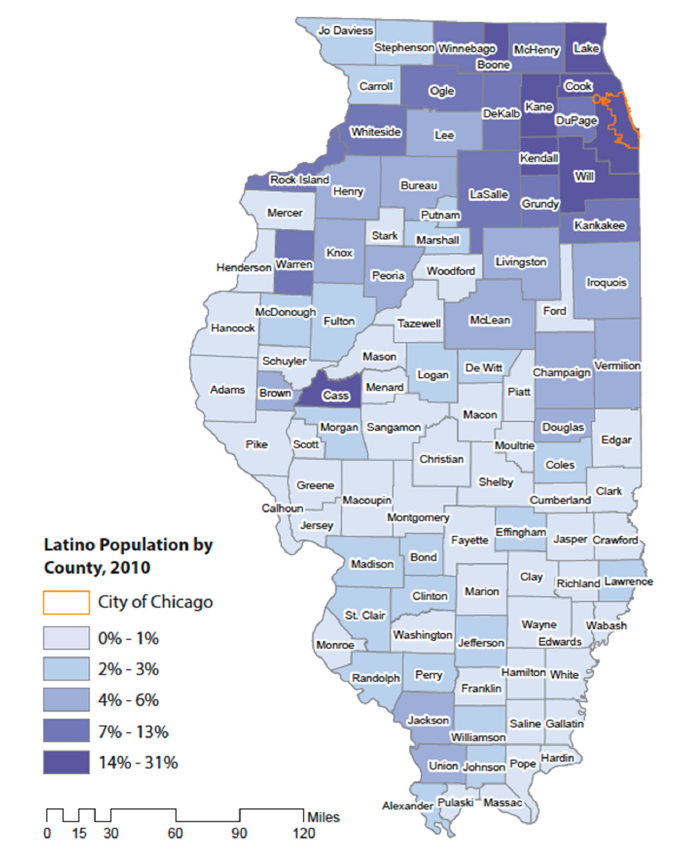
Figure 2. Latinx population in state of Illinois. Source: Authors.